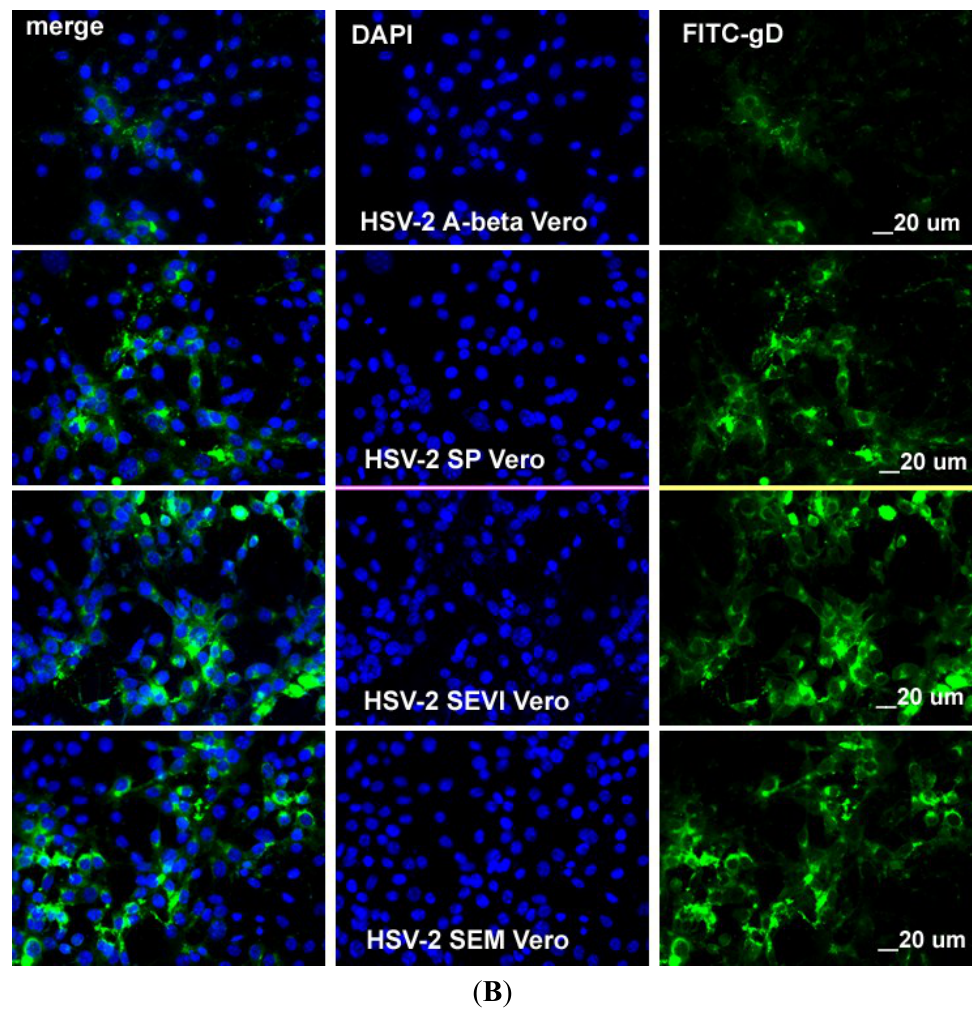
Figure 4. ( A ) Visualization of HSV-1 infection in Vero cells. The Vero cells were infected with HSV-1 at an MOI of 0.5 for 8 h following pre-treatment with either 10 μg/mL of A-beta (first row), 1:1000 SP (second row), SEVI (third row), or 10 μg/mL of SEM (fourth row) amyloids. The cells were fixed with 1% paraformaldehyde and stained with anti-gD-FITC in green and DAPI. The slides were observed under a fluorescence microscope (10× amplification lens), and pictures were taken to show infected cells (green) and total cells (DAPI). All scale bars correspond to 20 μm. The imaging experiments were performed three independent times, and the results as shown are representative of one of three experiments; ( B ) Visualization of HSV-2 infection in Vero cells. Similar to what was done for Figure 4A, except that the Vero cells were infected with